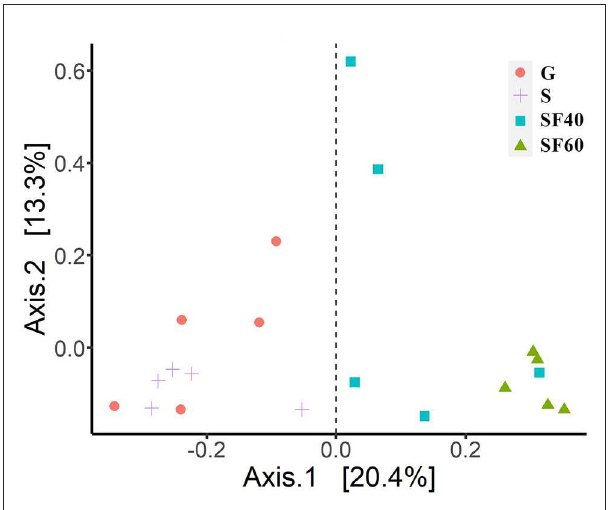
FIGURE1 Principal coordinate analyses of Bray–Curtis distances of AMF. G: grasslands; S: shrubs; SF40: secondary forest of 40a; and SF60: secondary forest of 60a.